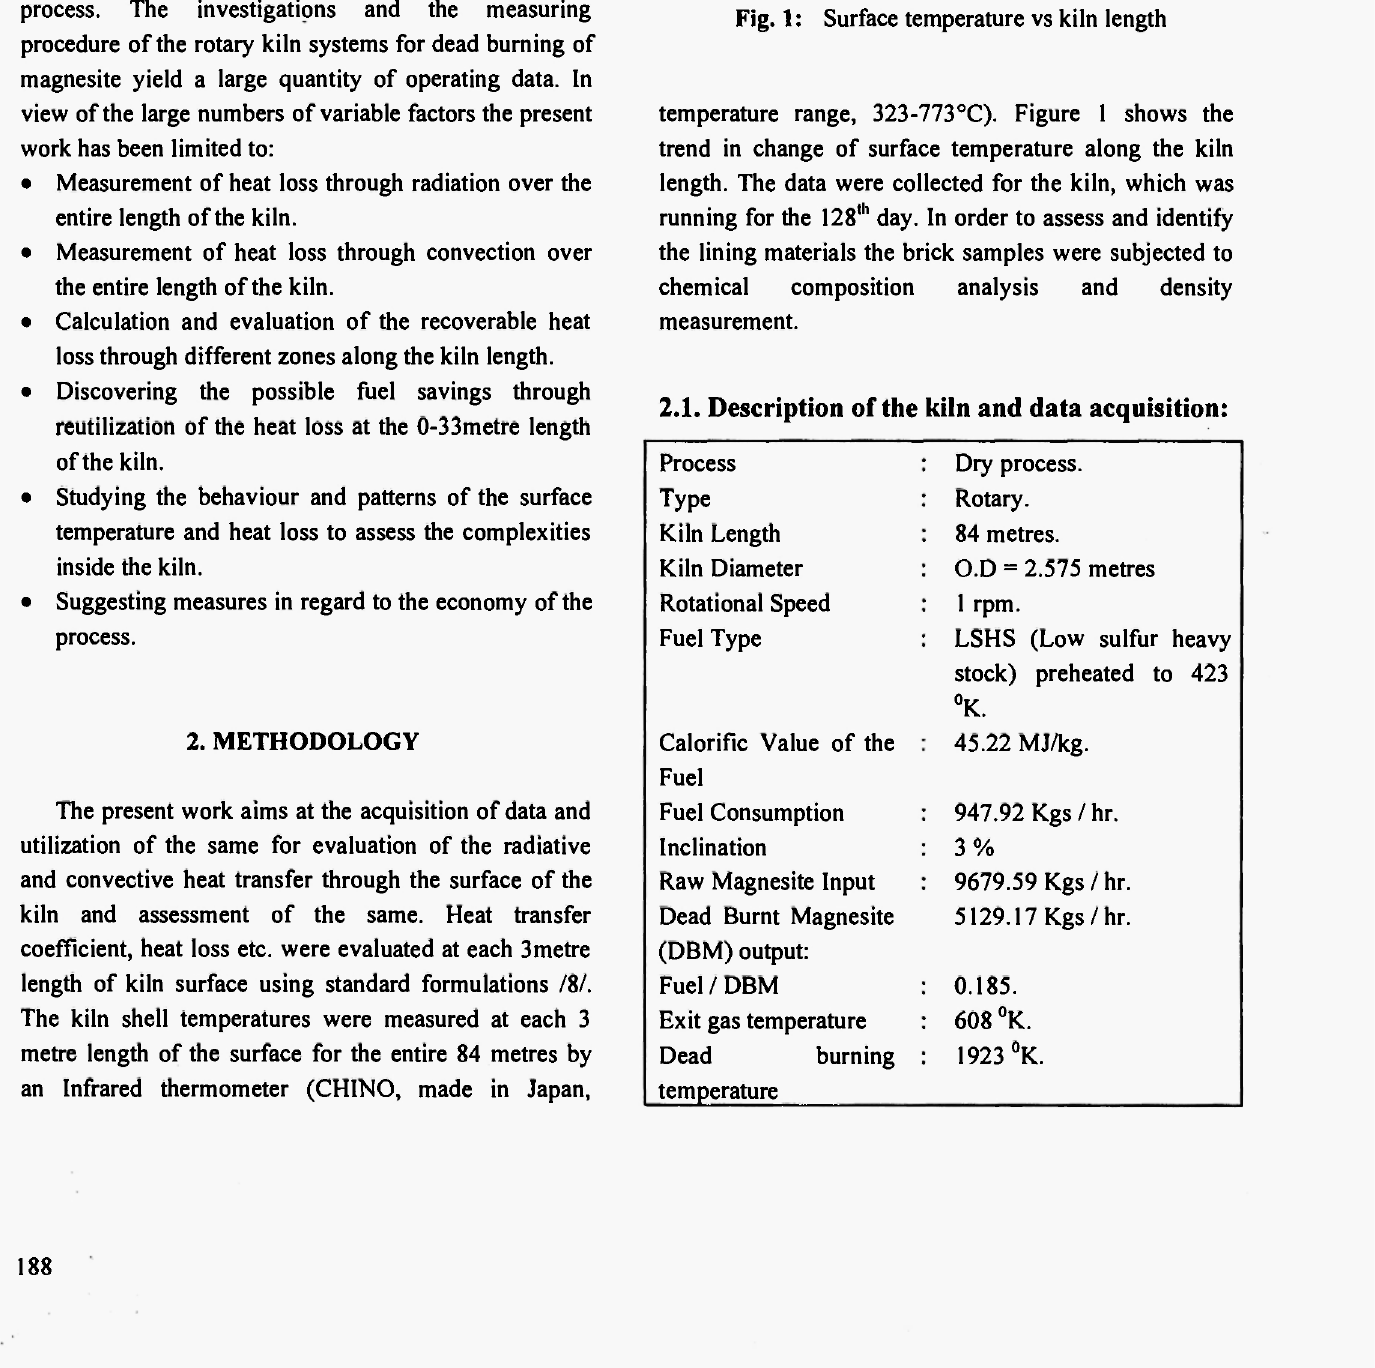
temperature range, 323-773°C). Figure 1 shows the trend in change of surface temperature along the kiln length. The data were collected for the kiln, which was running for the 128 th day. In order to assess and identify the lining materials the brick samples were subjected to chemical composition analysis and density measurement.